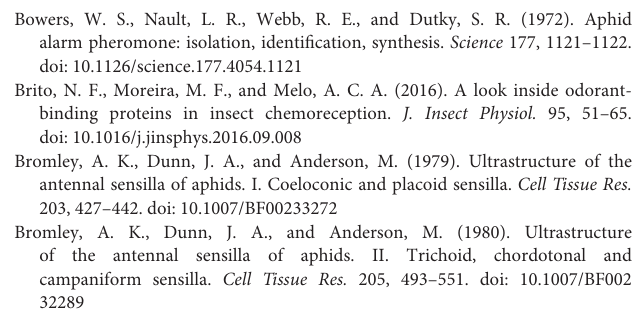
FIGURE S2 | Alignment of amino acid sequences of Megoura viciae and Acyrthosiphon pisum OBPs FIGURE S3 | SEM images showing the distribution of sensilla on M. viciae legs. Trichoid sensilla present a typical hair shape and are covered by a thin cuticle (arrowheads in (A–C) ). These sensilla show a peak with a rounded shape, without pores. Bar in (A) , 100 µ m; bar in (B) , 25 µ m; bar in (C) , 100 µ m; bar in (D) , 2 µ m FIGURE S4 | SEM images showing the distribution and morphology of different sensilla on winged M. viciae antennae. (A,B) Type II trichoid sensilla located on the terminal part of the antenna (arrowhead in (A) ) and on processus terminalis (B) with grooves on tip surface (arrowhead in (A’,B’) ). (C) Global view of primary rhinaria on 6th segment (arrowhead) and type II trichoid sensilla (arrow). (D) Details of small placoid sensilla (SP), and type I (CI) and type II (CII) coeloconic sensilla in the 6th segment surrounded by cuticular fringes (arrowheads). (E) Detail of porous structure on the surface of the large placoid sensillum (arrowheads). (F) Details of placoid sensillum of 5th segment and type I trichoid sensilla (arrow) with grooved surface (arrow in (F’) ). Porous structures were visible on the flat surface on the placoid sensillum of this segment (arrowhead). (G,H) Placoid sensilla (secondary rhinaria) on the 3rd segment (white arrowhead in (G,H) ) and trichoid sensilla type I (arrow in (G,H) ). Bars in (A,C,F) , 10 µ m; bars in (A’,B’,F’) , 500 nm; bar in (B) , 2 µ m; bars in (D,E) , 2 µ m; bar in (G) , 100 µ m; bar in (H) , 20 µ m. FIGURE S5 | Alignment of amino acid sequences of candidate OBPs from Megoura viciae. FIGURE S6 | RPS9 and RPL32 constant expression level in M. viciae body parts. FIGURE S7 | Relative expression level of M. viciae OBPs in different body parts (A,B) and in different nymphal instars (C,D) calibrated on RPL32 and RPS9 , respectively. OBP expression levels were quantified by RT-qPCR. Bars represent the standard deviation of the mean for 3 independent experiments. Significant differences are denoted by asterisks (Tukey’s test, ( ∗ p < 0.05, ∗∗ p < 0.01, ∗∗∗ p < 0.001)). (A,B) Lg, legs; Cd, cornicles-cauda; Hd, head; Bd, body; An, antennae. Calibrator sample: antennae. (C,D) I, 1st nymphal instar; II, 2nd nymphal instar; III, 3rd nymphal instar; IV, 4th nymphal instar; Ap, apterous adults; Al, alata adults. Calibrator sample: 1st nymphal instar. FIGURE S8 | Whole-mount immunolocalization experiments showing the absence of signal for MvicOBP8 in antenna (A) , MvicOBP1 and MvicOBP3 in the mouthparts (C,F) , MvicOBP1 , MvicOBP6 , MvicOBP7 in the cauda (D,G,I) , and in cornicles (E,H,J) . (B) Negative control in which the primary antibodies were omitted. Bars in (A,B) , 30 µ m; bars in (C,F) , 10 µ m; bars in (D,G,I) , 50 µ m; bars in (E,H,J) , 20 µ